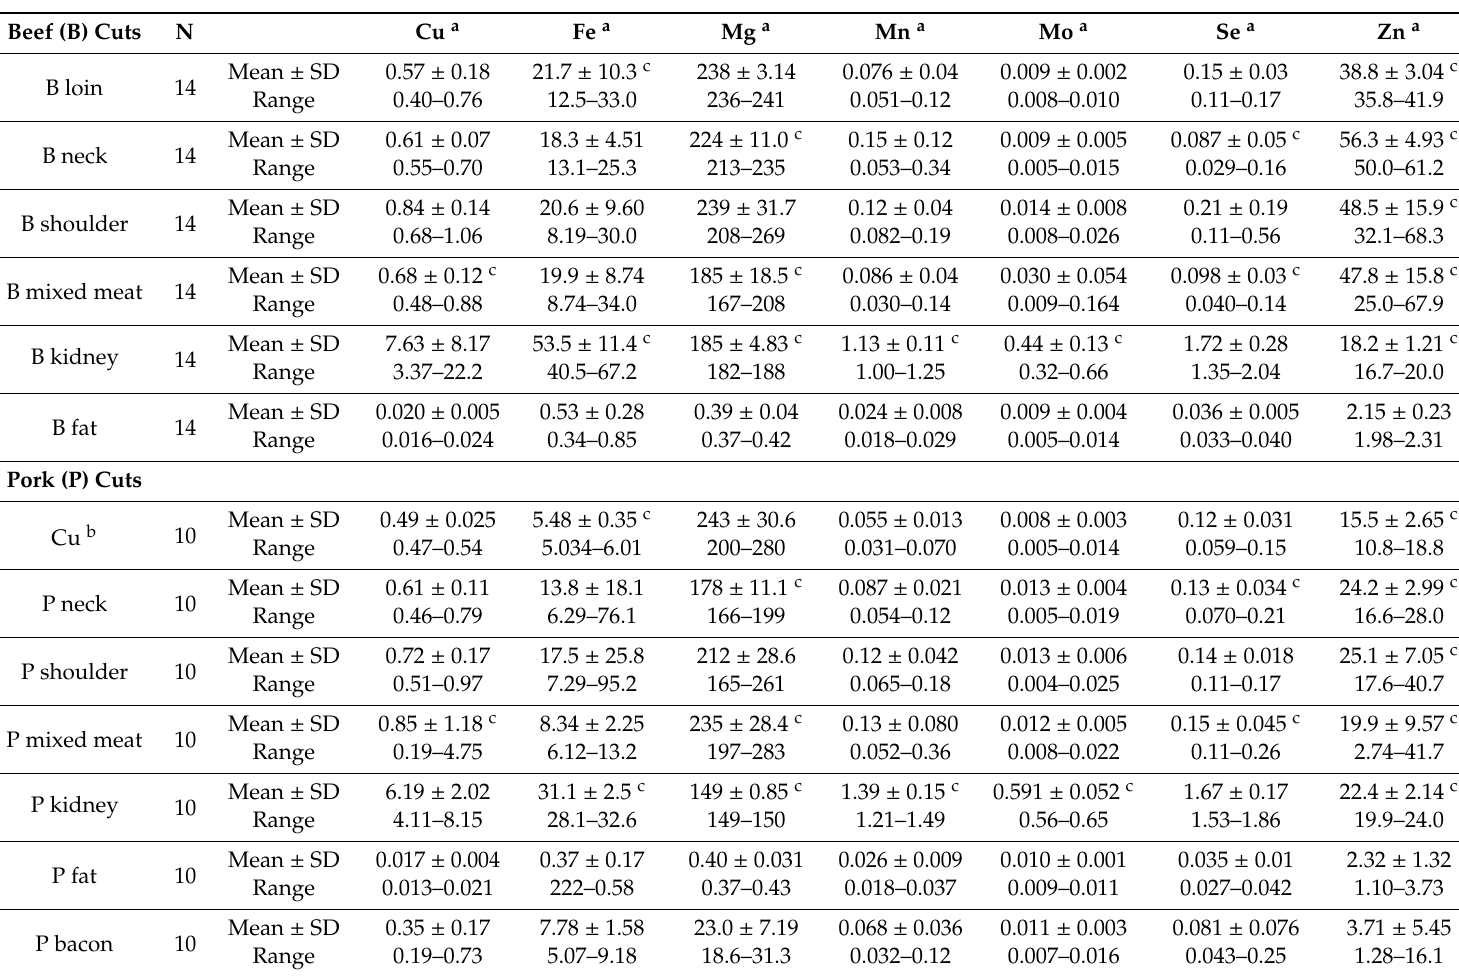
Table 3. Concentrations of essential elements (mg / kg; mean ± SD, min–max) in beef and pork cuts from markets of the Croatian